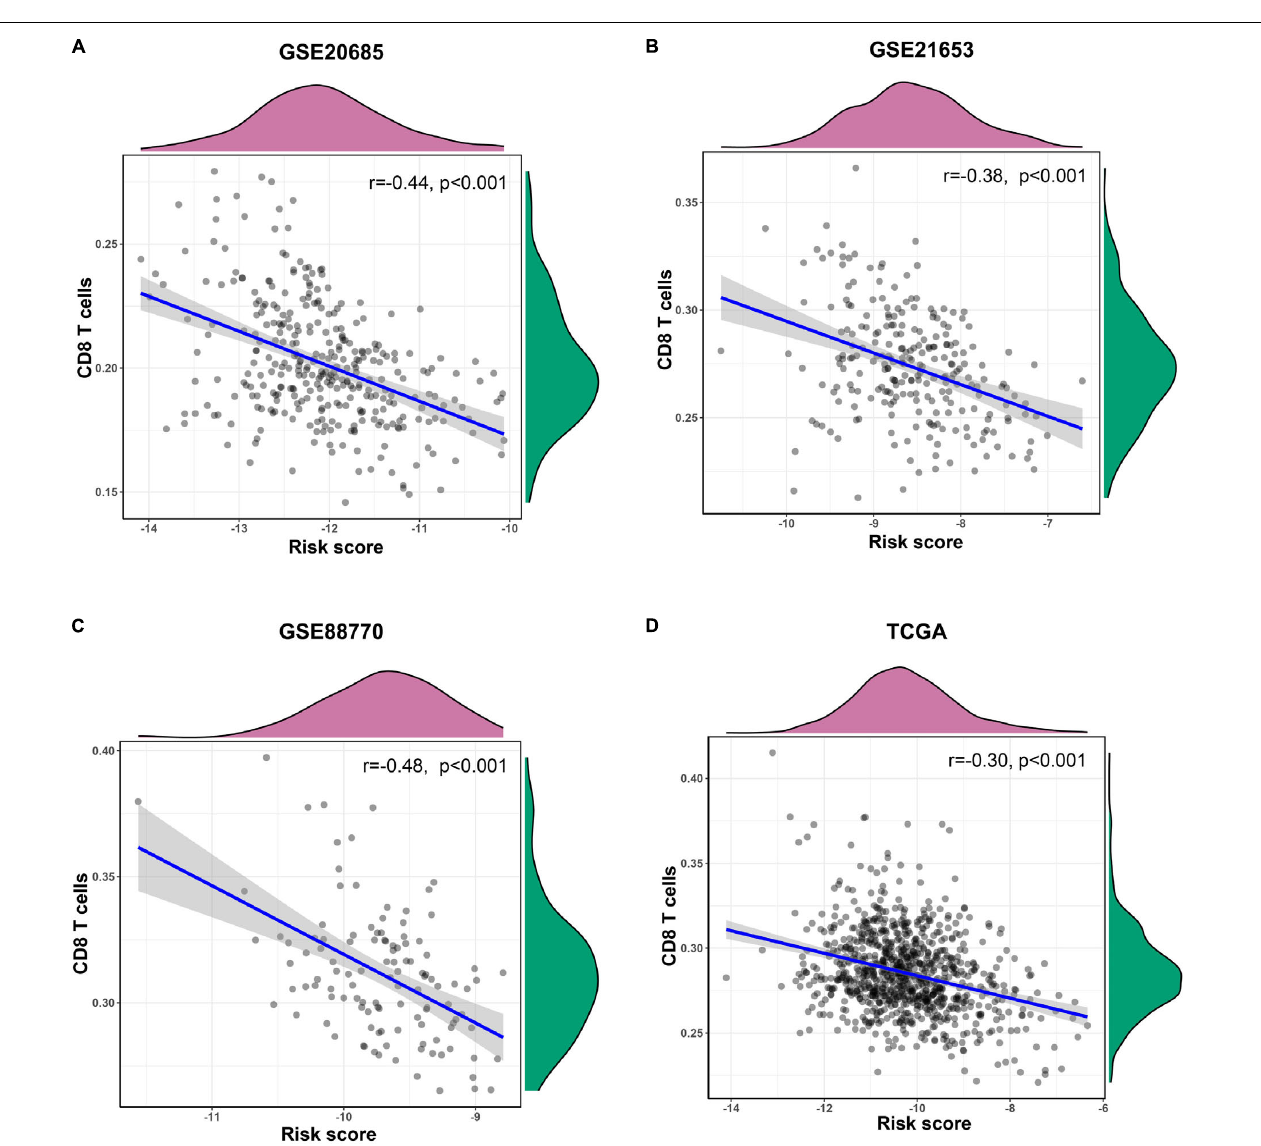
FIGURE 6 | The correlation of the six-lncRNA signature and CD8 T cells. (A–D) Pearson correlation analysis was conducted to identify the relationship between risk scores of the prognostic signature and enrichment scores of CD8 T cells in training and validation sets.